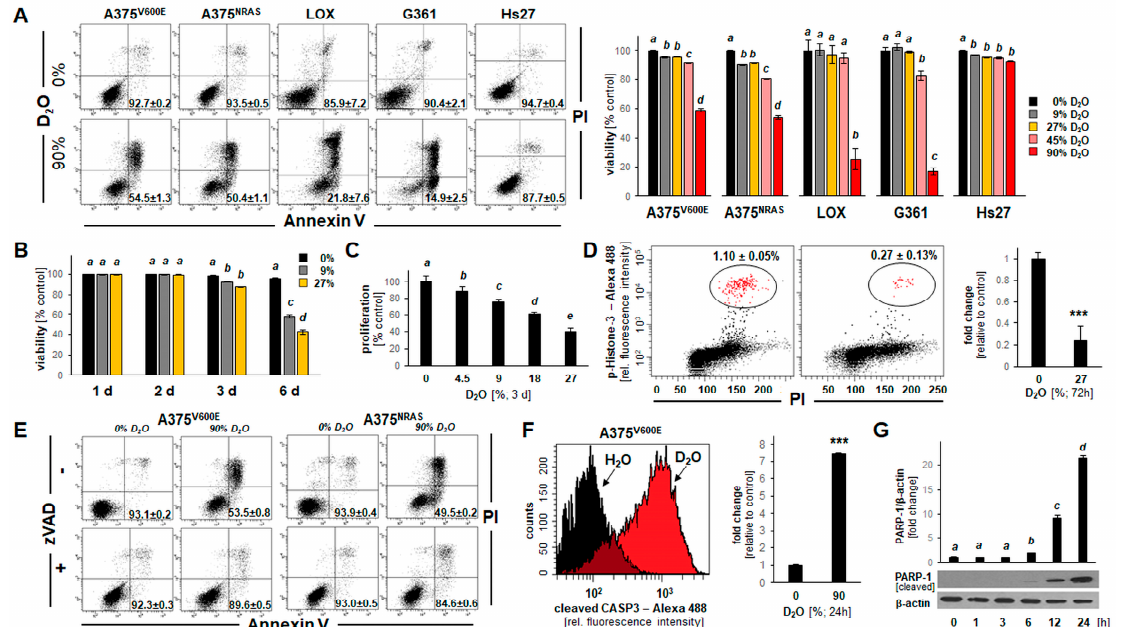
Figure 1. D 2 O-induced apoptosis in a panel of human malignant melanoma cells (A375 V600E , A375 NRAS , LOX-IMVI, and G361). ( A ) Impairment of cellular viability in response to culture in D 2 O (90%, 24 h) was monitored using flow cytometric analysis (annexin V-PI staining). Numbers in quadrants indicate percentage of viable cells (AV-negative, PI- negative) from a total of gated cells (mean ± SD, n = 3). Bar graph (right panel) indicates dose response of impaired cell viability (D 2 O ( ≤ 90%, 24 h)) ( n = 3). Human Hs27 dermal fibroblasts exposed to D 2 O served as non-transformed, non-malignant controls. ( B ) Impairment of cellular viability in response to long term exposure to D 2 O (27%, ≤ 6 days). Bar graph depicts dose response and time course (( ≤ 6 days); ( n = 3)). ( C ) Impairment of cellular proliferation (A375) in response to culture in D 2 O ( ≤ 27%, 3 days). ( D ) M-phase depletion as a function of culture in D 2 O (27%, 3 days) as assessed by phospho-histone H3 flow cytometry: individual histograms representative of three repeats (left panel); right panel: bar graph depiction of numerical analysis ( n = 3; p *** < 0.001). ( E ) D 2 O-induced (90%, 24 h) cell death (A375 V600E versus A375 NRAS ) in the absence or presence of zVAD-fmk (40 µ M). ( F ) D 2 O-induced (90%, 24 h) induction of pro-caspase 3 cleavage as examined in A375 V600E cells by flow cytometry (left panel: representative histograms; right panel: bar graph depiction of numerical analysis ( n = 3; p *** < 0.001). ( G ) Time course of PARP-1 cleavage in response to D 2 O-exposure (90%, ≤ 24 h) in A375 cells (bottom panel: immunoblot; top panel: bar graph depiction of numerical analysis ( n =